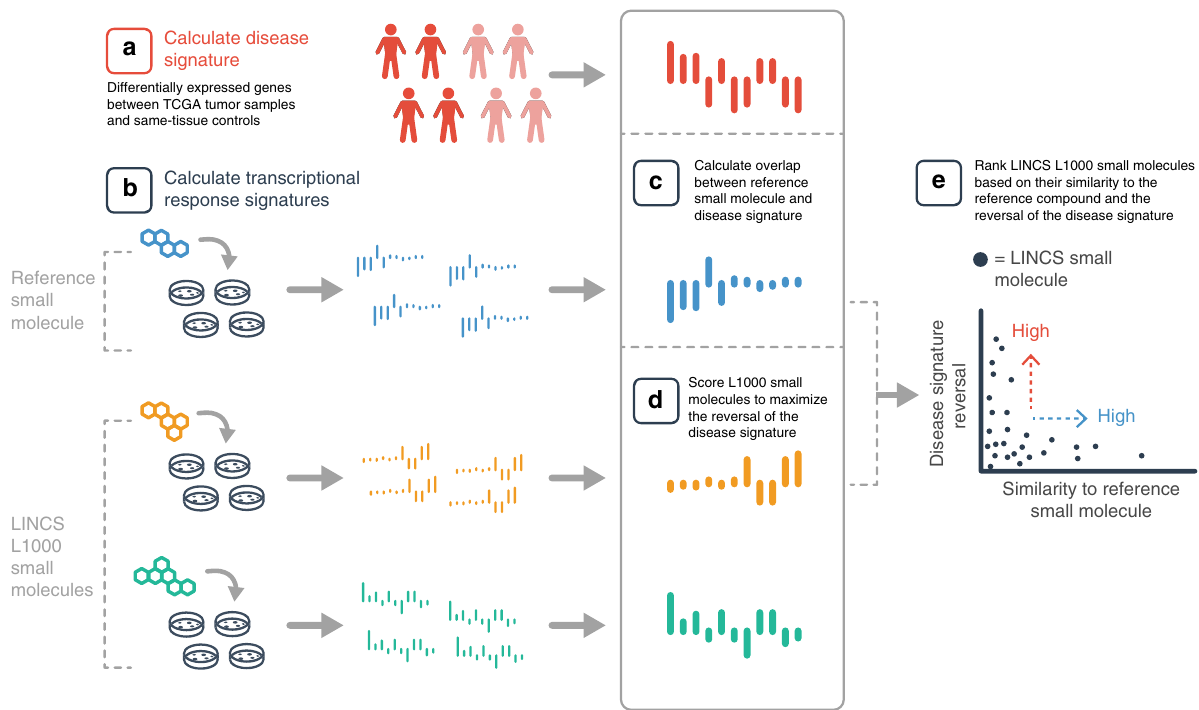
Fig. 1 SynergySeq work fl ow for identifying synergistic drug combinations using disease discordance and drug concordance. a A disease signature is calculated by identifying the differentially expressed genes between tumor samples and same-tissue controls. b Transcriptional consensus signatures (TCS) are calculated for a reference small molecule and the LINCS L1000 small molecules. c The overlap between the reference TCS and the disease signature is calculated. d The LINCS L1000 small molecules are ranked to maximize the reversal of the disease signature. e The LINCS L1000 small molecules are plotted based on their similarity to the reference small molecule and the reversal of the disease